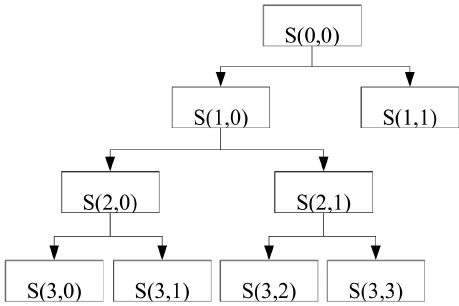
Figure 4. Wavelet analysis